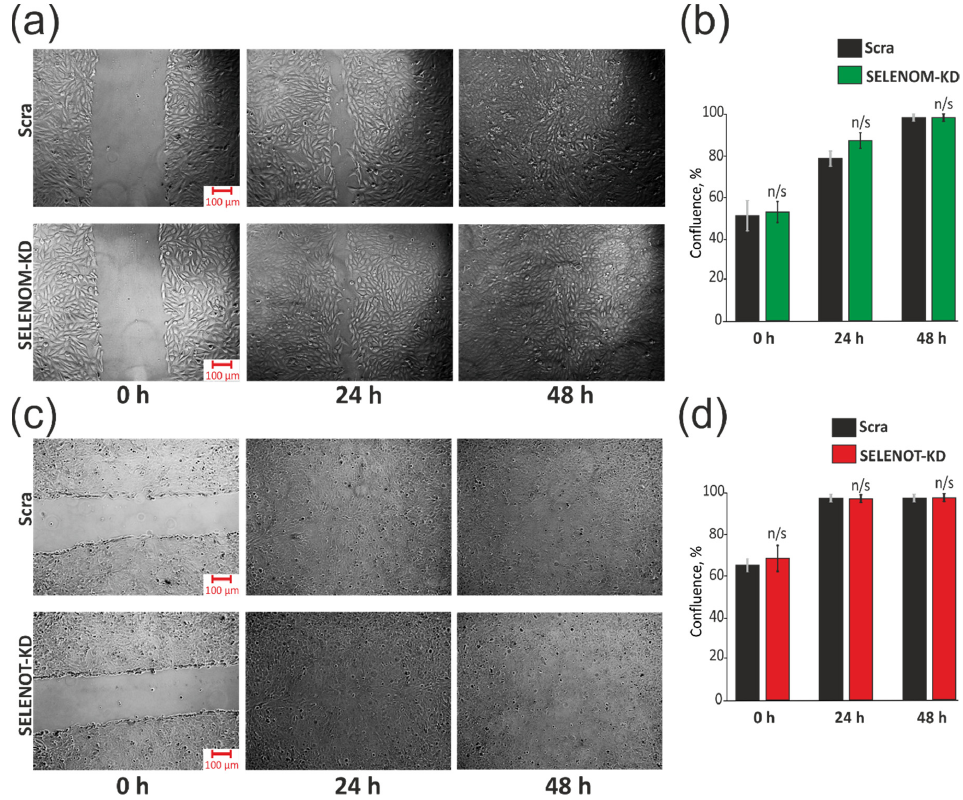
Figure 2. Effects of SELENOM-KD and SELENOT-KD on A-172 cells migration by the “wound healing assay”. The rate of “wound healing” and the formation of a monolayer ( a ) and quantitative assessment of the rate of “wound healing” ( b ) after 24 and 48 h in A-172 cells with SELENOM-KD, with SELENOT-KD ( c , d ) respectively) and in control cells (Scra). Three independent replications of this series of experiments were carried out. Comparison of KD groups vs. Scra: n/s—data not significant ( p >